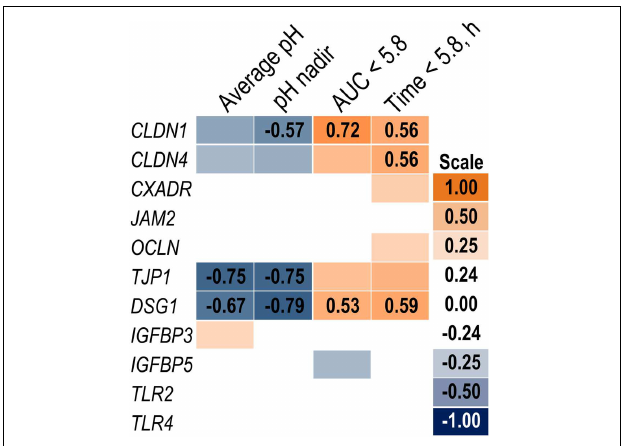
FIGURE 8 | Association heat map between the change in rumen epithelium gene expression over time (day 6 – day 1) and ruminal pH response on day 5 using Pearson correlations. All correlation coefficients greater than 0.5 or less than − 0.5 are listed. The scale bar colors denote the correlation coefficients with 1 indicating a perfect positive correlation (orange) and − 1 indicating a perfect negative